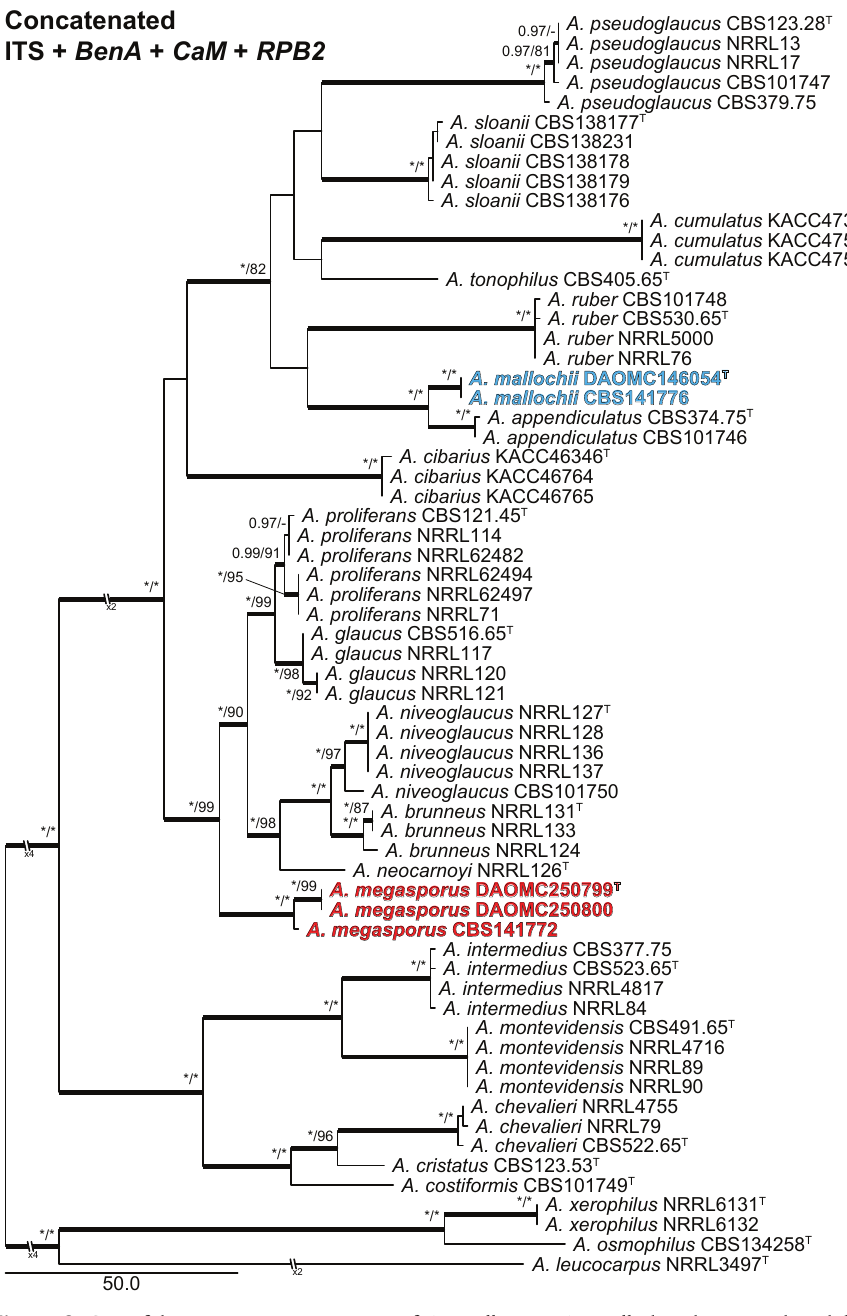
Figure 2. One of the most parsimonious trees of Aspergillus sect. Aspergillus based on a combined dataset of ITS, BenA , CaM and RPB2 . The tree was rooted to A. xerophilus , A. leucocarpus and A. osmophilus . Support in nodes higher than 80% bootstrap values and 0.95 posterior probabilities are shown above thickened branches. New species are shown in bold and colour, while ex-type strains are followed by T